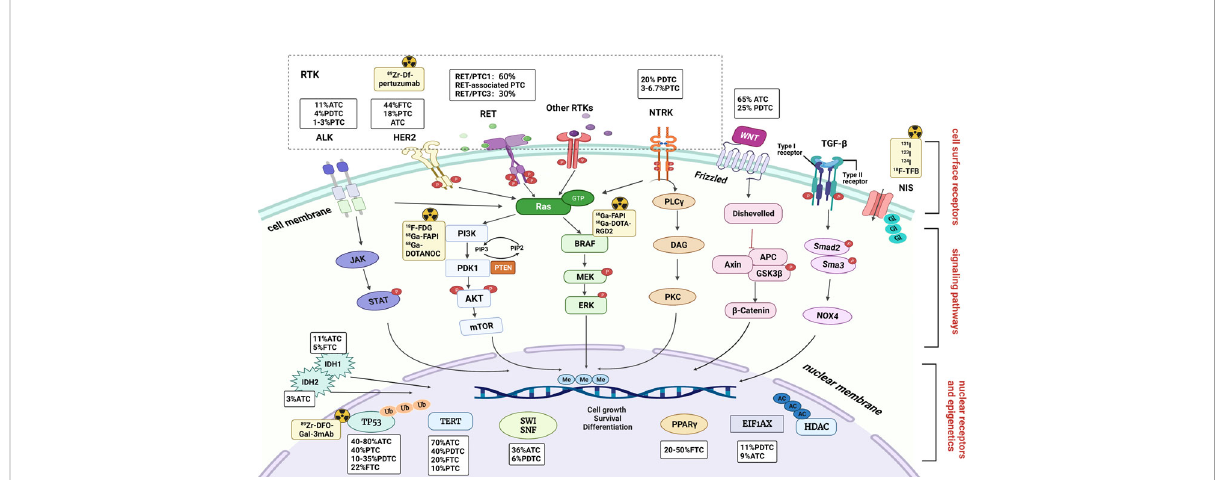
FIGURE 1 Mechanisms and molecular imaging involved in dedifferentiation of thyroid cancer. Molecular modi fi cations and genetic mutations are described at the three levels of cell surface receptors, signaling pathways, nuclear receptors, and epigenetics. The incidence in different histologies are indicated in boxes. And the radioactive sign indicates the target for molecular imaging. RTK, receptor tyrosine kinase; ALK, anaplastic lymphoma kinase; HER2, human epidermal growth factor receptor 2; NTRK, neurotrophic tyrosine receptor kinase; NIS, sodium/ iodide symporter; P, phosphorylation; JAK, Janus kinase; STAT, signal transducers and activators of transcription; ERK, extracellular signal- regulated kinase; PLC g , phospholipase C- g ; DAG, diacylglycerol; PKC, protein kinase C; TGF- b , transforming growth factor- b ; PI3K, phosphoinositide 3-kinase; APC, adenomatous polyposis coli; AXIN1, axis inhibition protein 1; GSK3 b , glycogen synthase kinase 3 b ; NOX4, NADPH oxidase 4; PPAR- g , peroxisome proliferator activated receptor gamma; HDAC, histone deacetylase; TERT, telomere reverse transcriptase; IDH, isocitrate dehydrogenase; EIF1AX, eukaryotic translation initiation factor